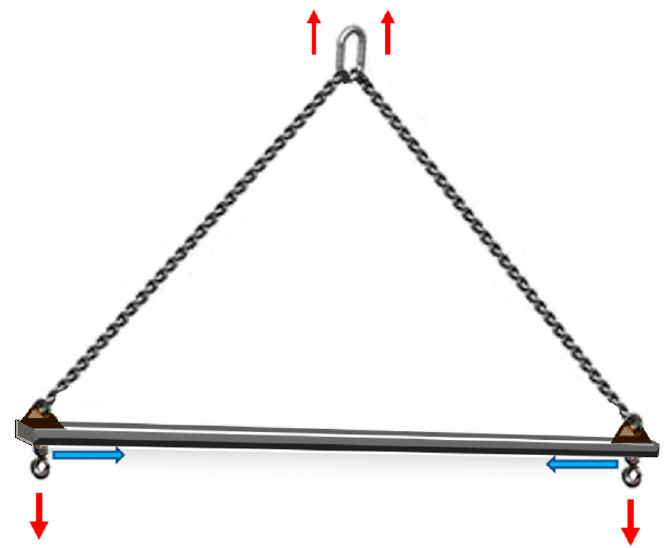
Figure 1. A schematic diagram of a spreader beam used in a lifting operation, indicating the conversion of lifting loads (shown by the vertical red arrows) into compressive forces (shown by the horizontal blue arrows) in the beam and tensile forces in the slings.